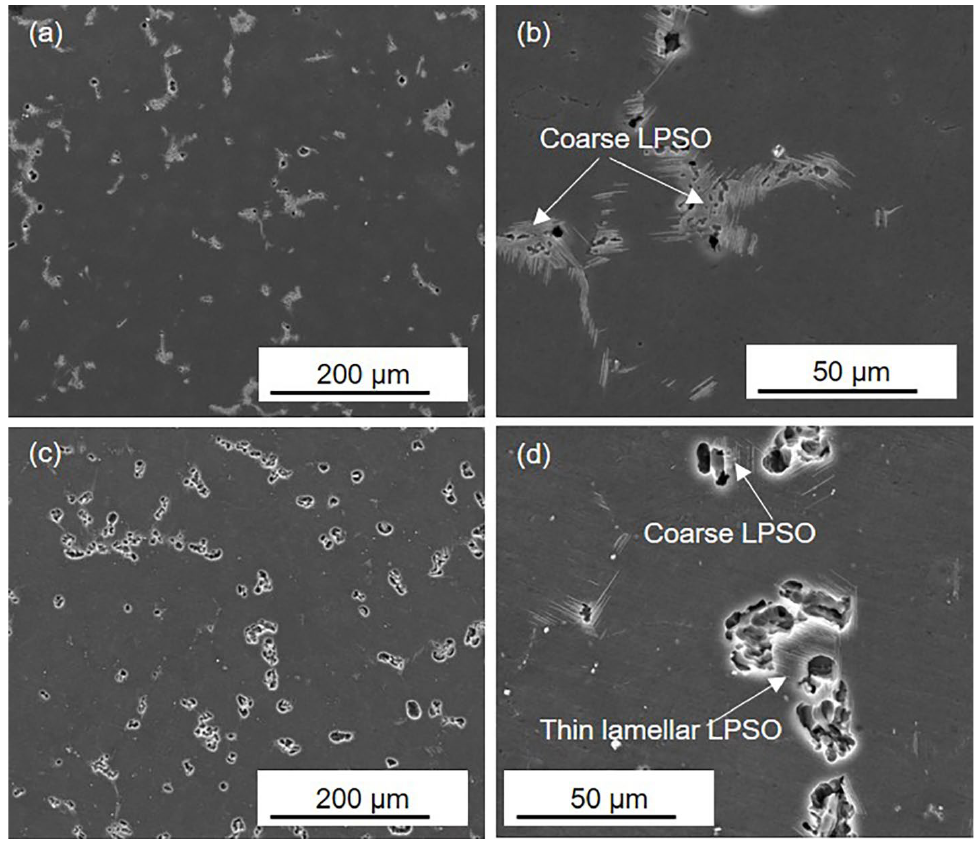
Figure 4. SEM images of ( a , b ) the HOMO and ( c , d ) LPSO samples after 1 h immersion.